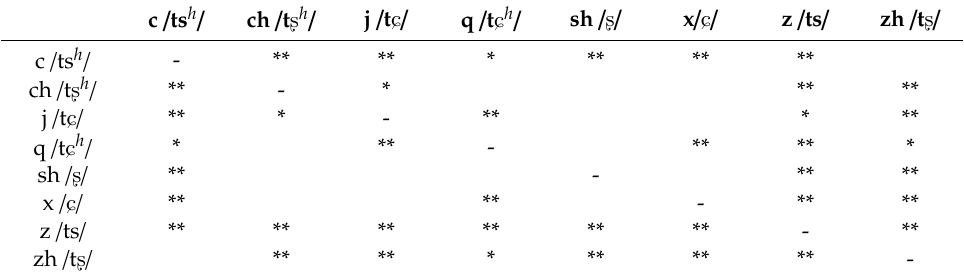
Table 5. Pairwise comparisons of di ff erences between the consonants in production (** p < 0.01, * p < 0.05).